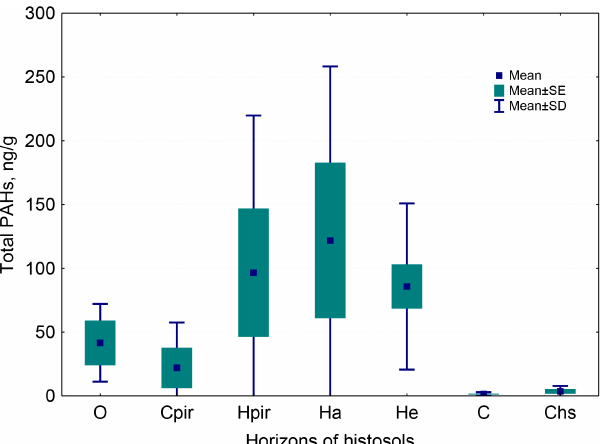
Figure 9. The profile distribution and PAH composition in post- pyrogenic histic podzols, wildfire 2010 (pit